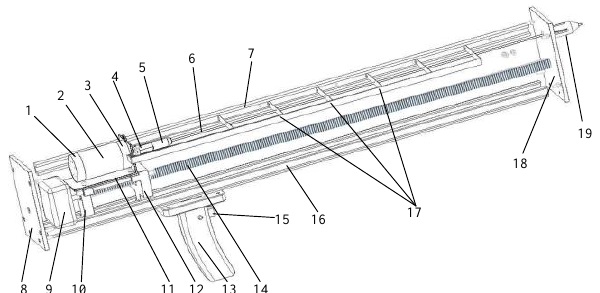
Figure 3. The internal structure of the microdestructive tree-ring measurement system. (1) Photoelectric rotary encoder; (2) direct current (DC) servomotor; (3) planetary gear reducer; (4) coupling; (5) drill bit clamp; (6) microdrill; (7) support plate guide; (8) back cover; (9) stepper motor; (10) rear sliding base; (11) motor base; (12) front sliding base; (13) control handle; (14) turn-screw; (15) switch button; (16) main rail; (17) support plate; (18) front cover; (19) needle copper sleeve.